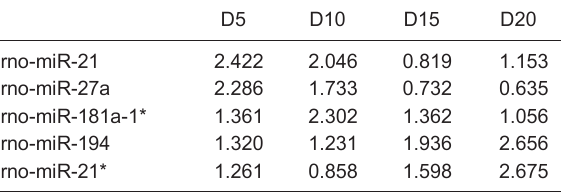
Table 1. Upregulated miRNAs during heart hypertrophy in